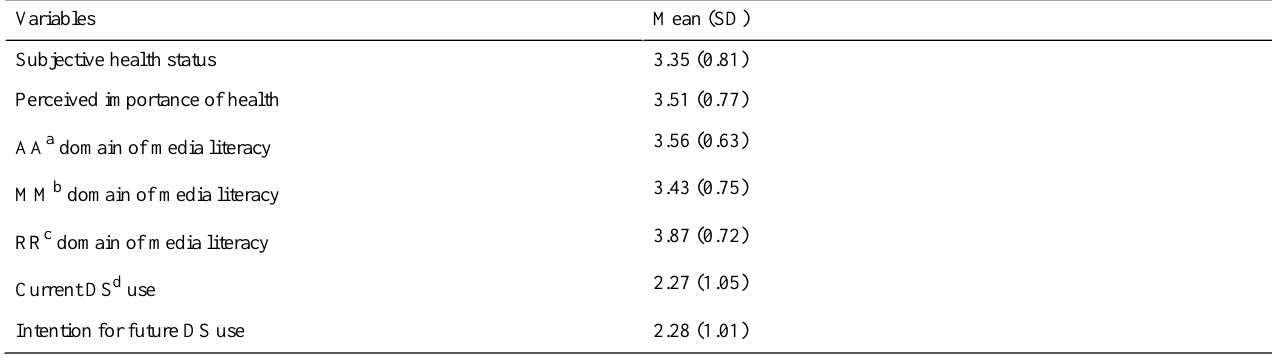
Table 2. Descriptive statistics for the categorical variables.